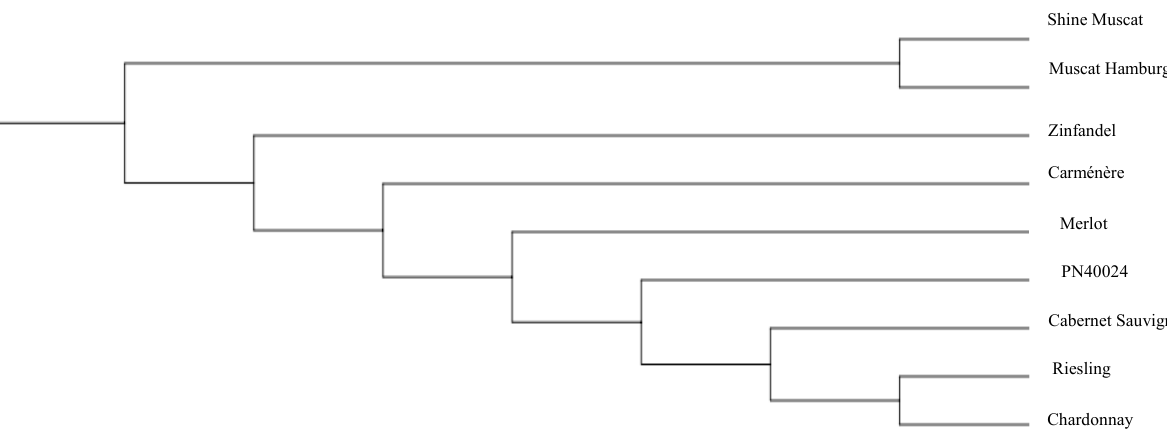
Figure 5. Construction of a grape variety evolutionary tree based on a simple repeat sequence.